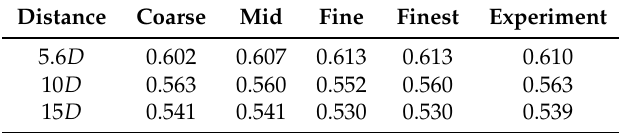
Table 4. Mesh independence study results (value of R c ) for different